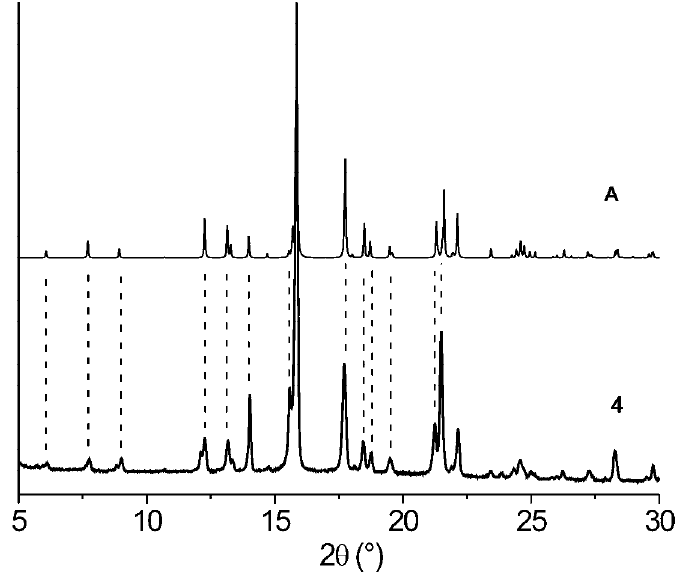
Figure 6. Experimental powder diffraction pattern of the anhydrous form 4 compared with the simulated powder pattern A generated from the single crystal